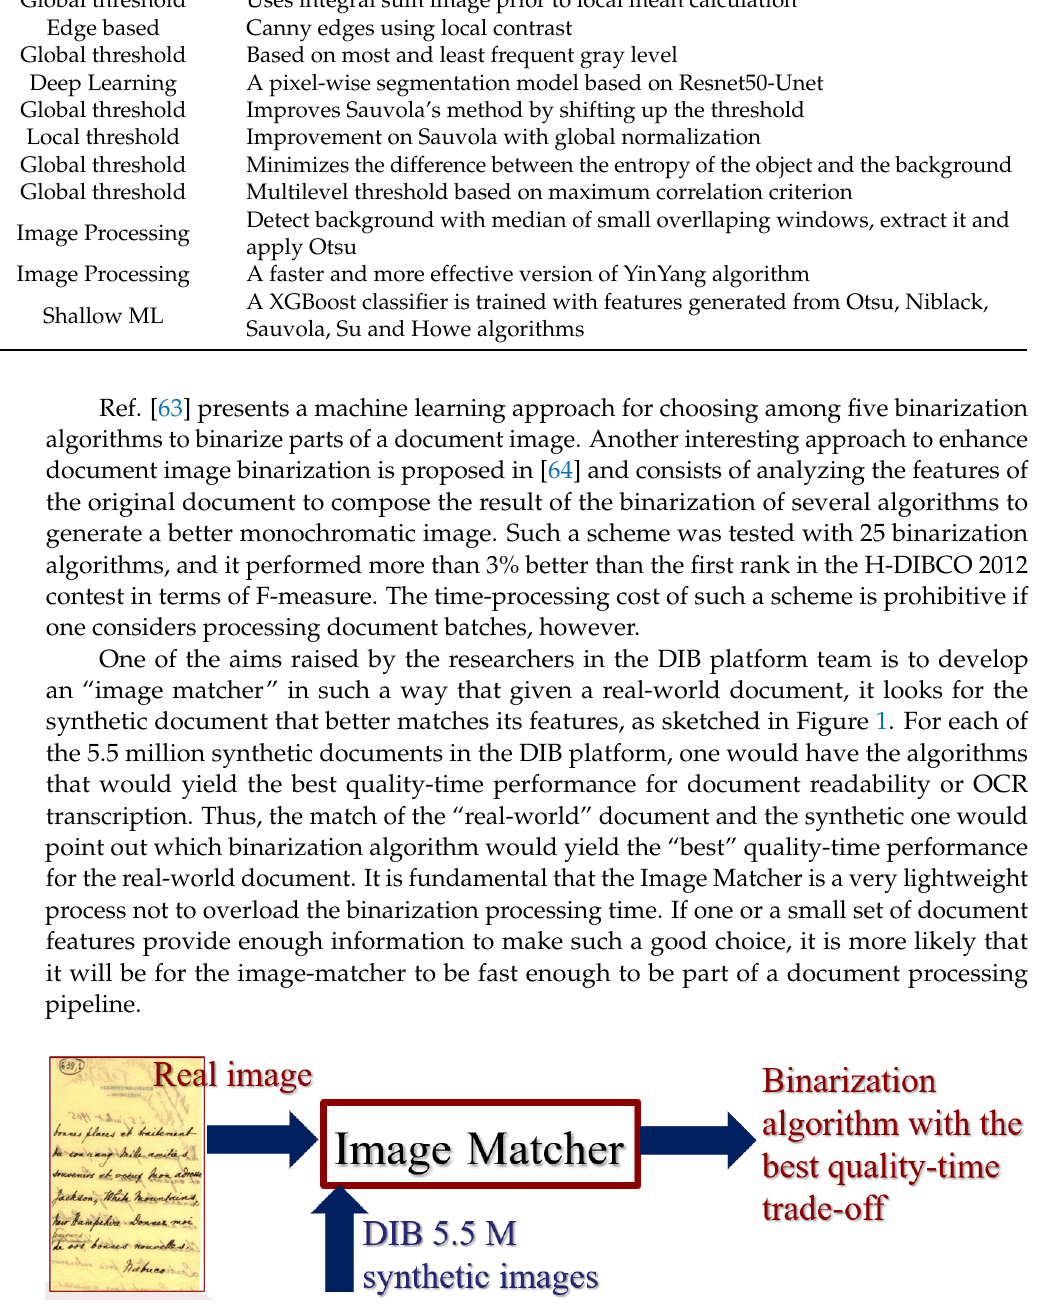
Figure 1. DIB image